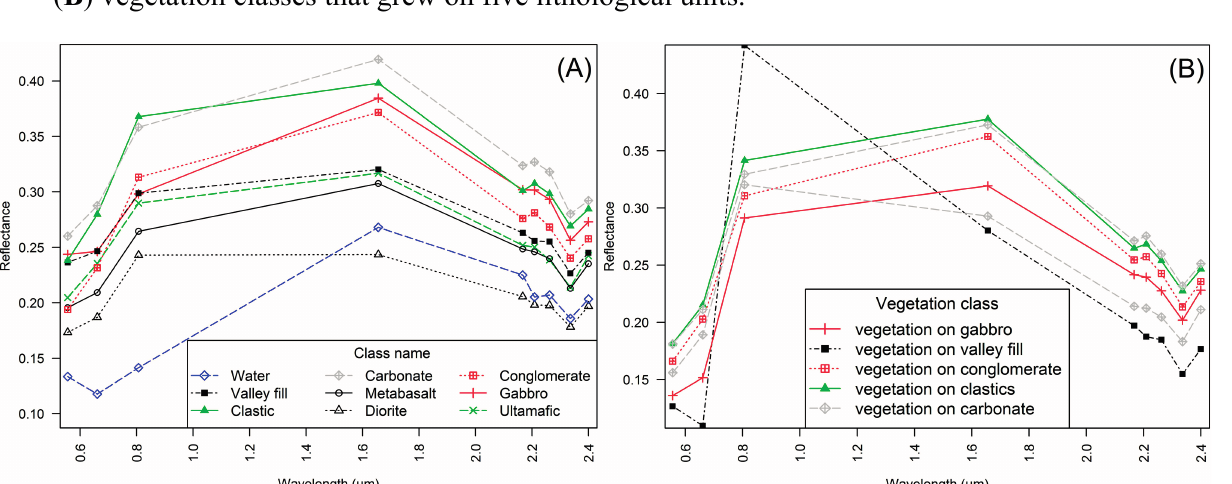
Figure 4. Average of surface reflectance based on training samples selected from ASTER data acquired on 24 August 2003 for ( A ) eight lithological units and water; and ( B ) vegetation classes that grew on five lithological